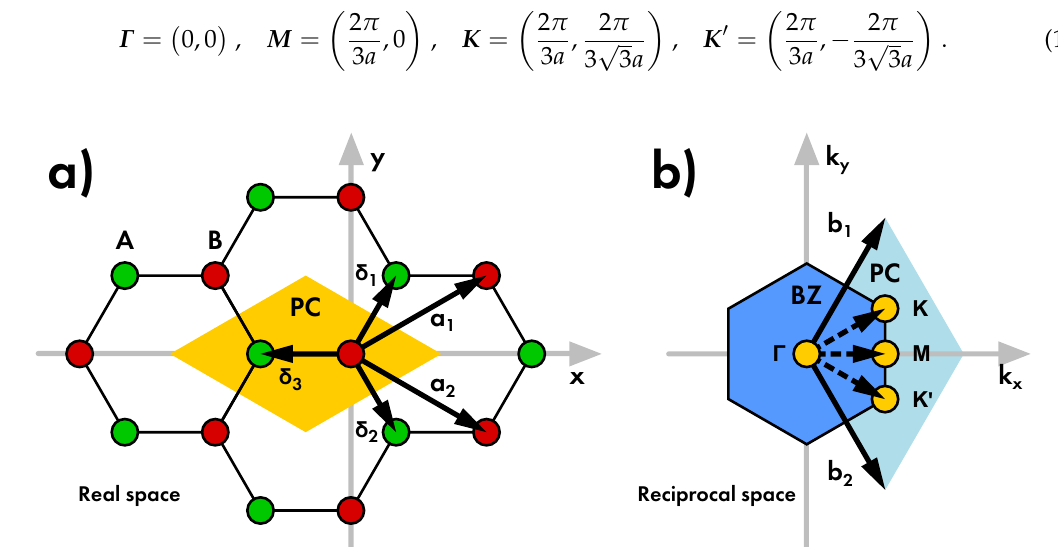
Figure 8. ( a ) Hexagonal structure of graphene in the real space. The atoms are distinguished in accordance to the two sub-lattices A (green) and B (red) to which they belong. Primitive vectors ( a 1 and a 2 ) and first near-neighbor vectors ( δ 1 , δ 2 and δ 3 ) are marked. The primitive cell (PC) is highlighted. ( b ) Corresponding reciprocal lattice of graphene. Primitive vectors ( b 1 and b 2 ), and the high-symmetry points Γ , K , K (cid:48) , and M (yellow) are marked. The PC and the first Brillouin zone (BZ) are highlighted. Adapted with permission from Ref. [23]. Copyright (2009) American Physical